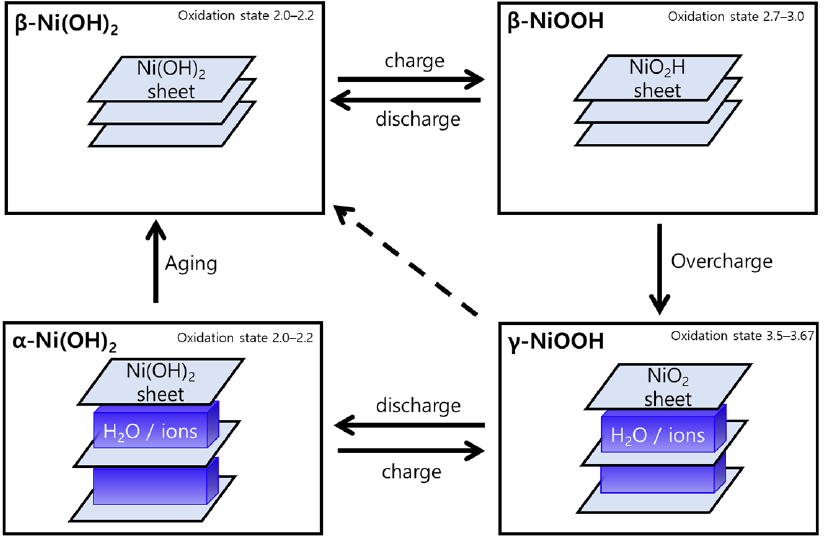
Figure 5. Bode’s scheme expresses the Ni(OH) 2 /NiOOH redox transformation [44].